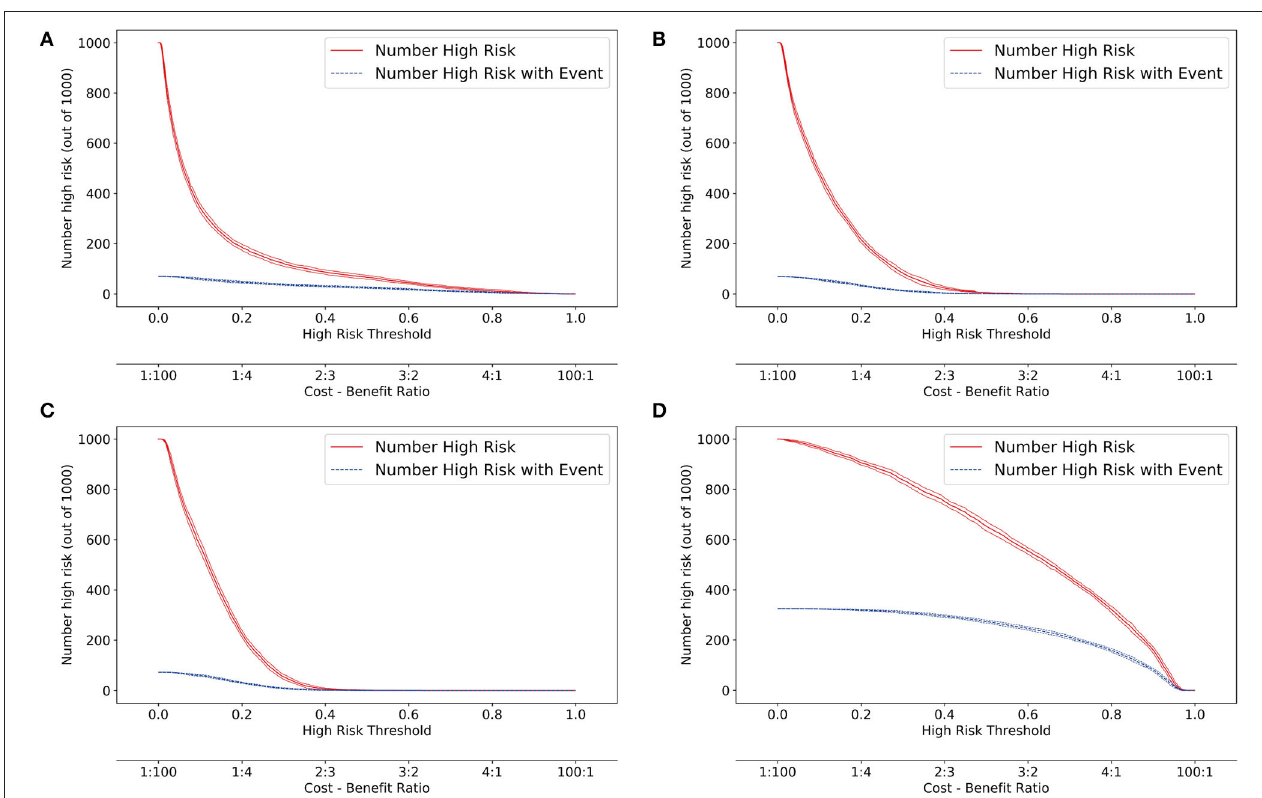
FIGURE 6 | Clinical impact curve (CIC) of the XGBoost model. (A) class 0 ( < 30 days); (B) class 1 (30 days − 1 year); (C) class 2 (1–5 years); (D) class 3 ( ≥ 5 years). The red curve (number of high-risk individuals) indicates the number of people classified as positive (high risk) by the model at each threshold probability; the blue curve (number of high-risk individuals with outcome) is the number of true positives at each threshold